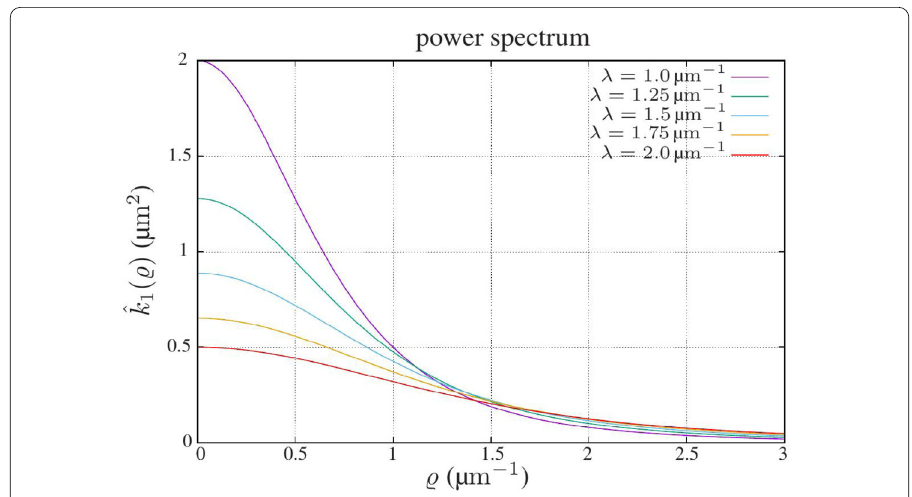
Figure 2 Graphs of the power spectrum ˆ k 1 ( (cid:7) ) given by (7) for constant ν = 1 and varying λ